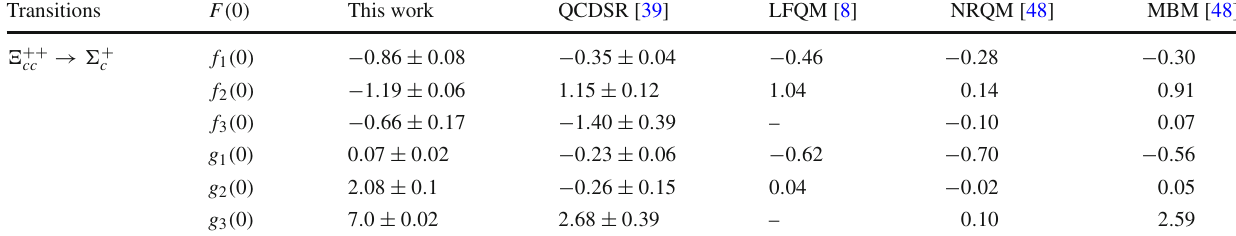
Table 7 Comparison of (cid:2) bb and (cid:2) bc decay form factors derived in this work with the results from QCD sum rules (QCDSR) [39] and light-front quark model (LFQM)